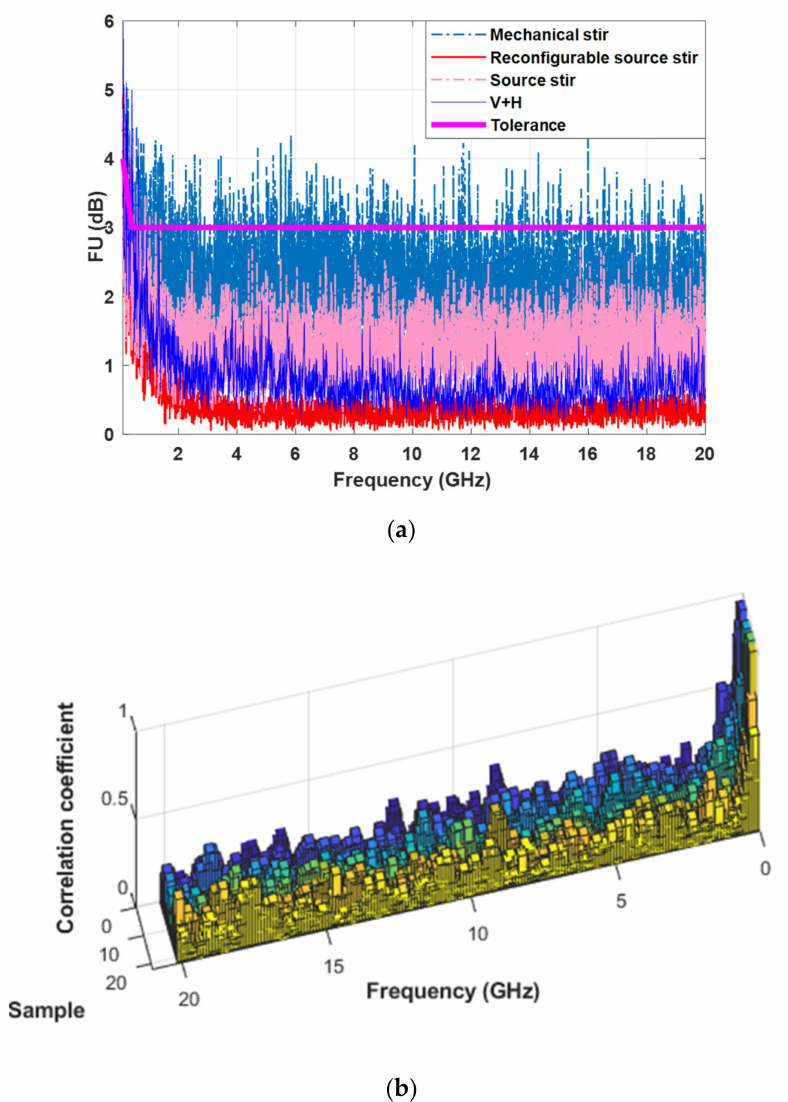
Figure 3. Mechanical stir means the mechanical stirring of the antenna array; source stir means the source stirring of the antenna array; V + H means the conventional mechanical stirring. ( a ) Measured FU for different stirring methods; ( b ) Correlation coefficient of the seven antennas on the outer circle of antenna